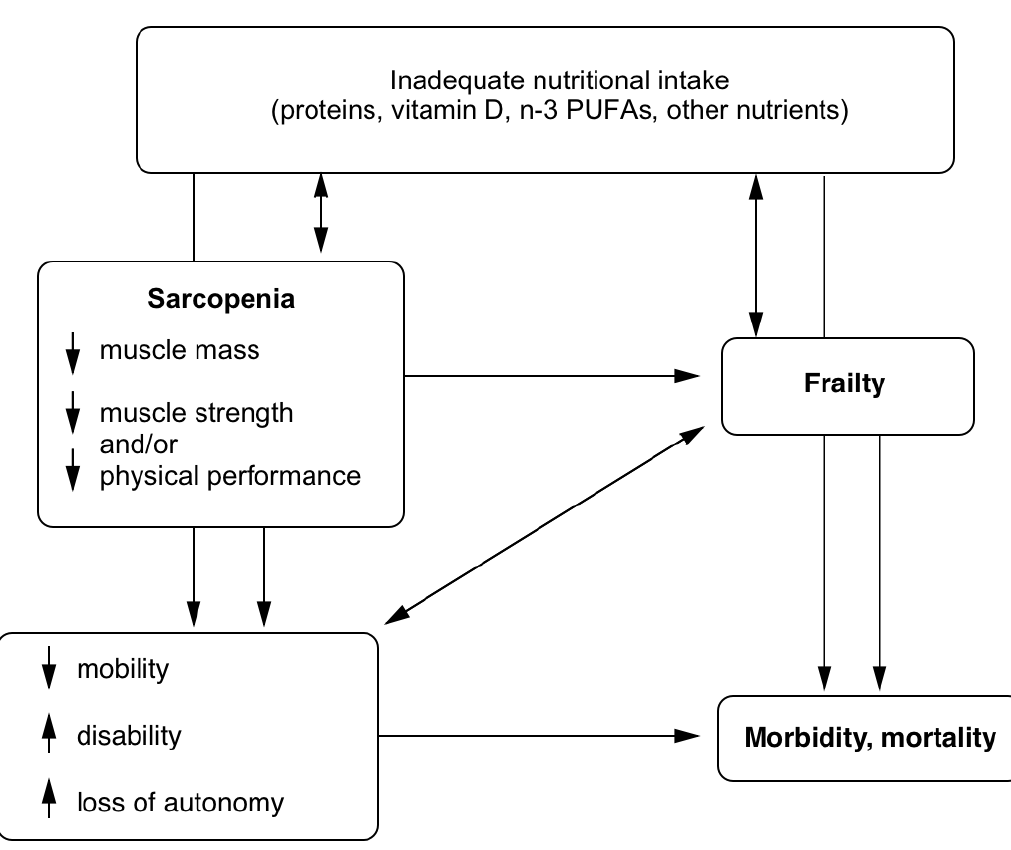
Figure 1. Potential role of nutrition on the physical health of older adults. Short arrows within boxes: increase or decrease. Long arrows between boxes: may lead to. Double-sided arrows: the relationship may be bidirectional. Arrows passing through boxes: factors in box could be mediators.